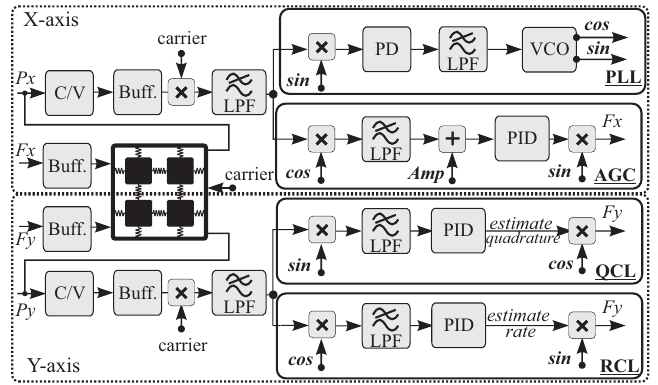
Figure 13. Control structure for operating devices in the rate mode. AGC and PLL were activated along the drive axis of the device (X-mode). QCL and RCL were activated along the sense axis of the device